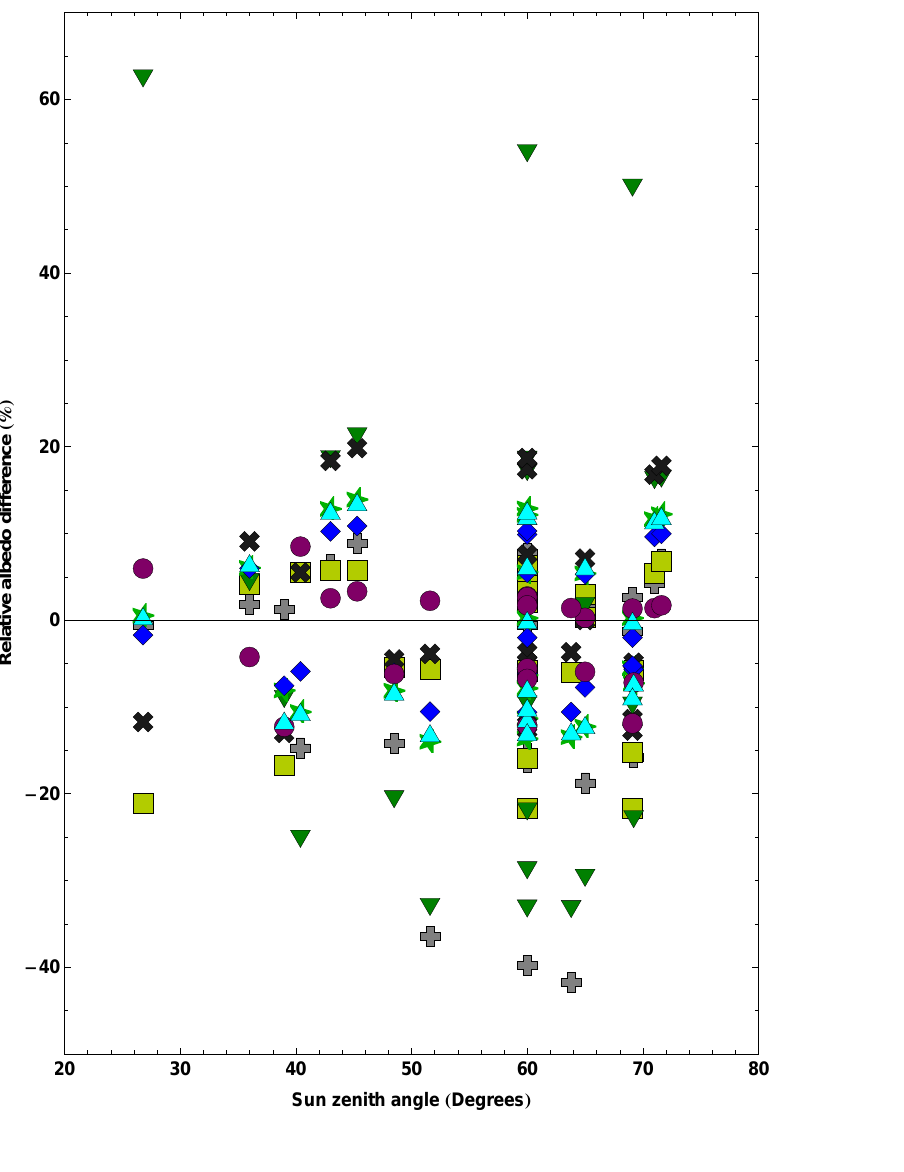
Figure 8. The relative difference between two broadband albedo estimates and the sun zenith angle for various targets. We derived the two albedo values as follows: (1) by using various broadband conversion formulae from Liang [25] and (2) by directly integrating of the measured BRF